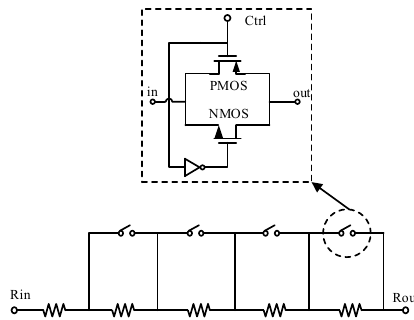
Figure 5. Schematic diagram of the digital controlled resistor array.